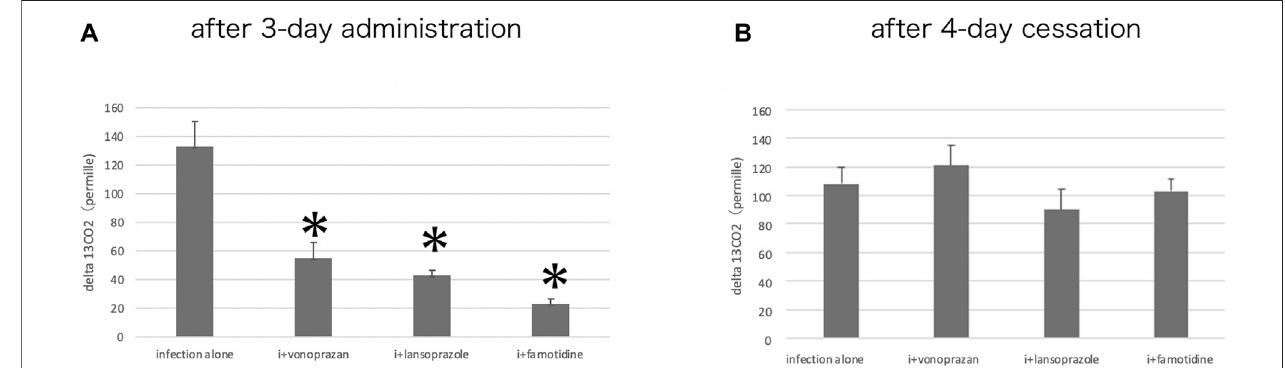
FIGURE 10 | Alteration of the urease activity by acid suppressants. (A) By the urea breath test, a signi fi cant interaction was found between infection alone and administered agents (F = 47.1; p = 0.001 by one-way ANOVA). Post hoc analyses (Bonferroni correction) revealed that the infection-alone group is signi fi cantly larger than the other three groups (* p < 0.001) after three-day administration. (B) Cessation of the administration for 4 days resulted in the recovery of the urease activity in all drug-administered